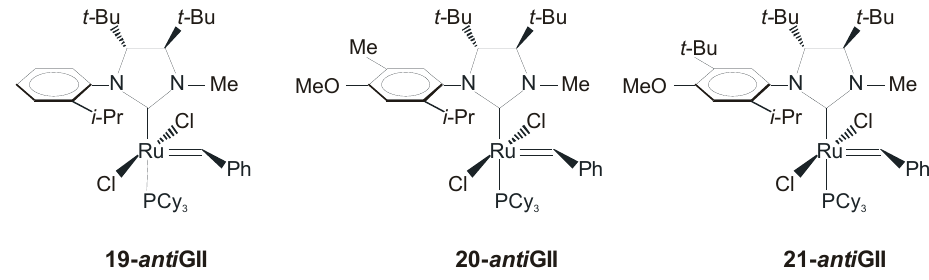
Figure 14. Catalysts bearing C 1 -symmetric monodentate NHC.